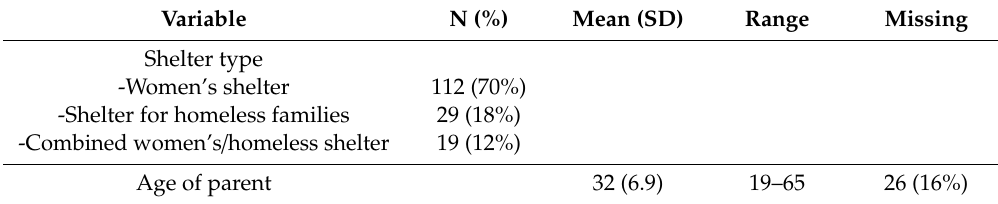
Table 1. Characteristics of the study population: continuous variables presented as means with standard deviations (SD); categorical variables as numbers (n) with percentages